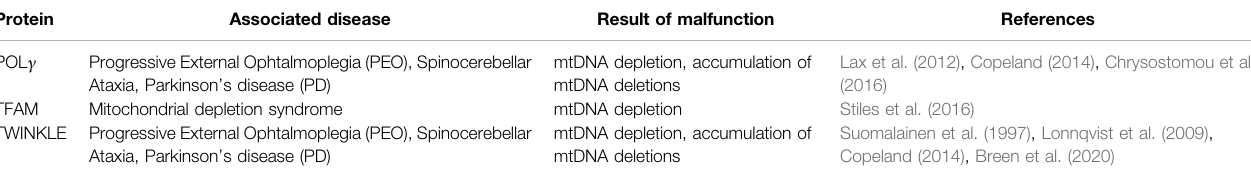
TABLE 1 | Proteins related to disturbed mtDNA